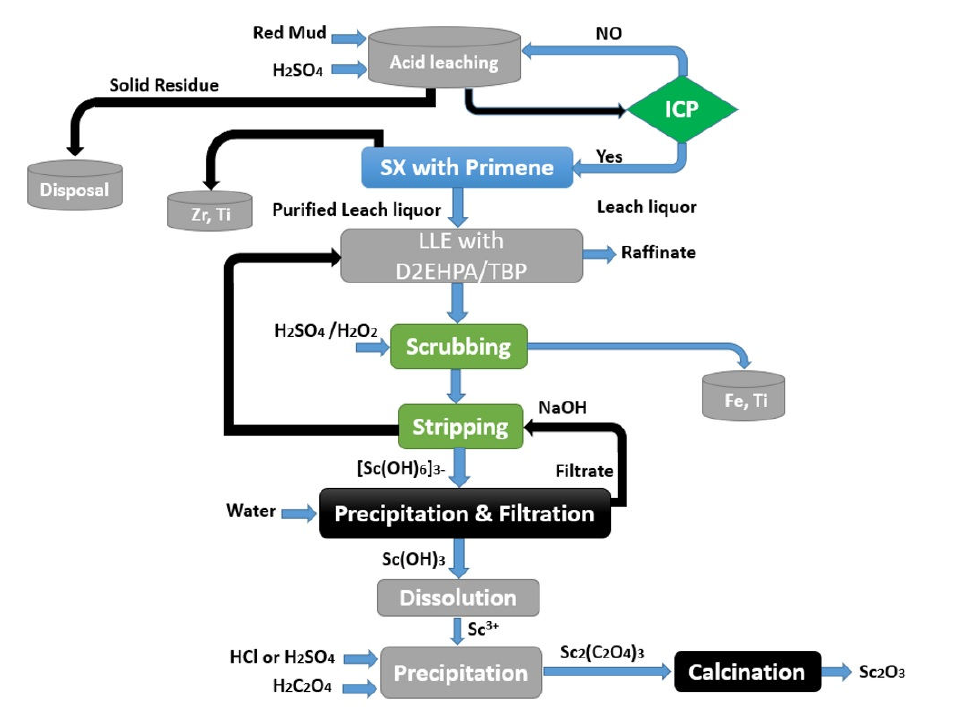
Figure 20. The proposed flow-chart of scandium separation from Australian RM, adapted from